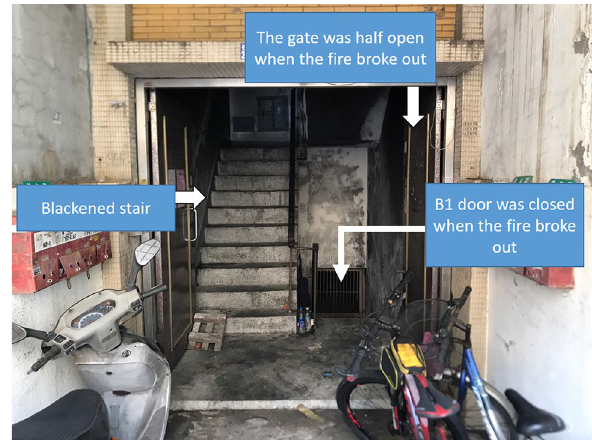
Figure 4. Blackened gate on the first floor.